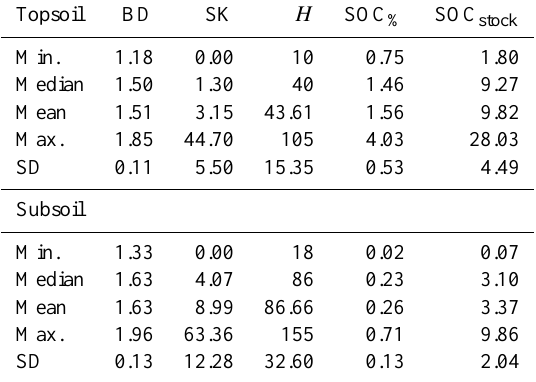
Table 1. Descriptive statistics for the observed target variables. BD: total bulk density (gcm − 3 ) ; SK: particles > 2mm (%); SOC % : SOC concentration (%); H : stock thickness (cm); and SOC stock : mass of organic carbon per unit area of soil (kgm − 2 )